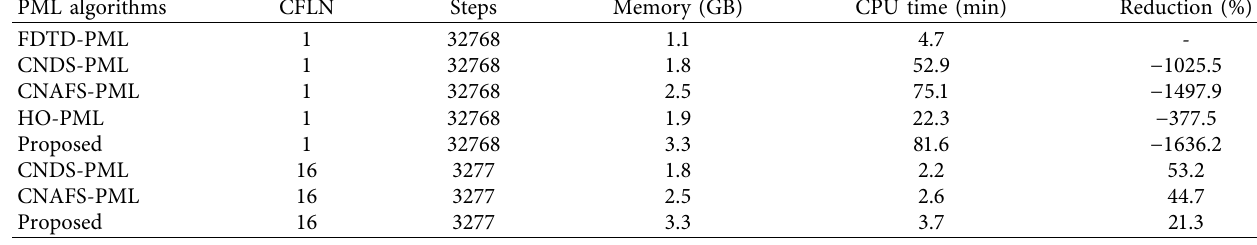
Table 2: The memory consumption, CFLN, CPU time, iteration steps, and time reduction obtained by different PML algorithms. PML algorithms CFLN